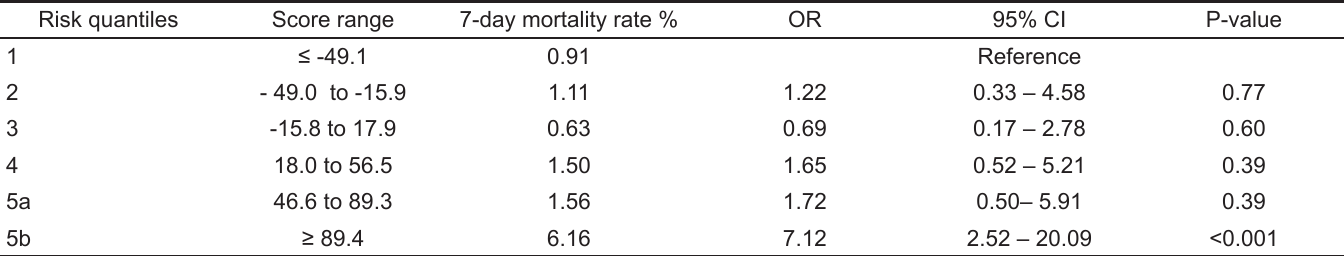
Table 3. Results of mixed-effects logistic regression model for 7-day mortality (n = 3,320).